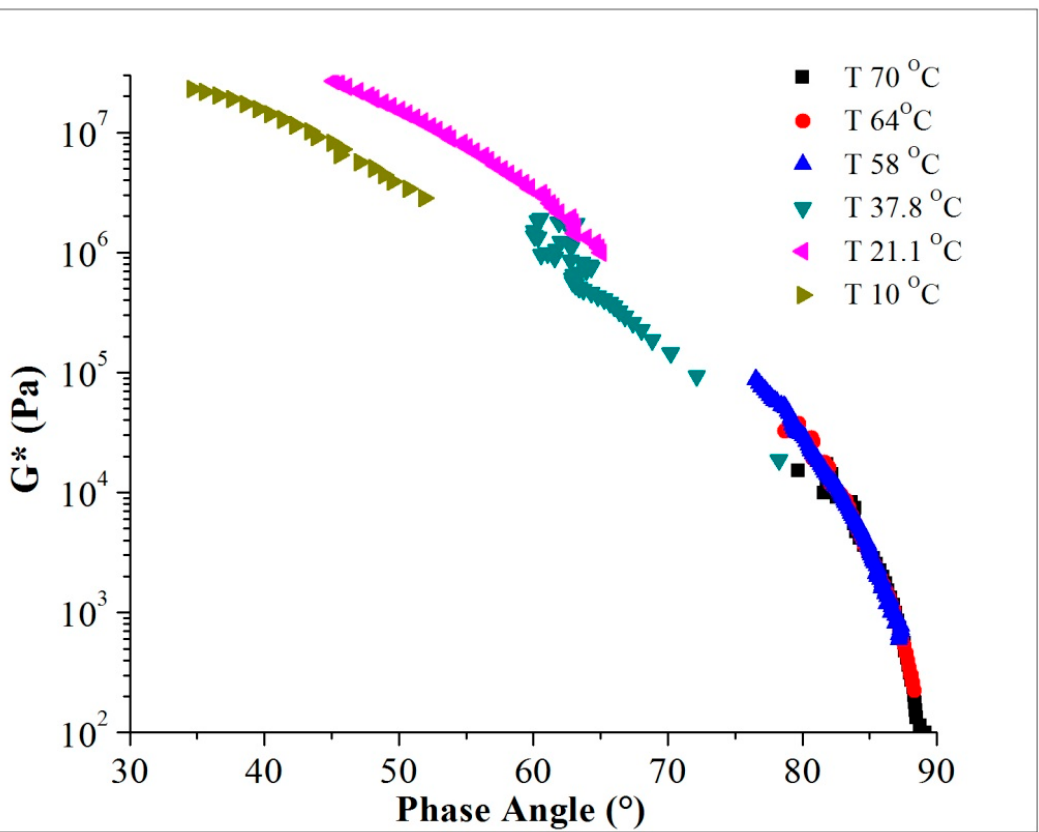
Figure 8. Semi-log black space diagram of MMB20.